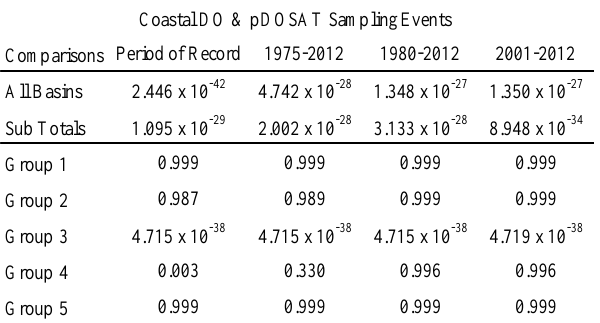
Table 3. Coastal DO & pDOSAT Chi Square test for Independence. Test was conducted at various spatial and temporal scales.